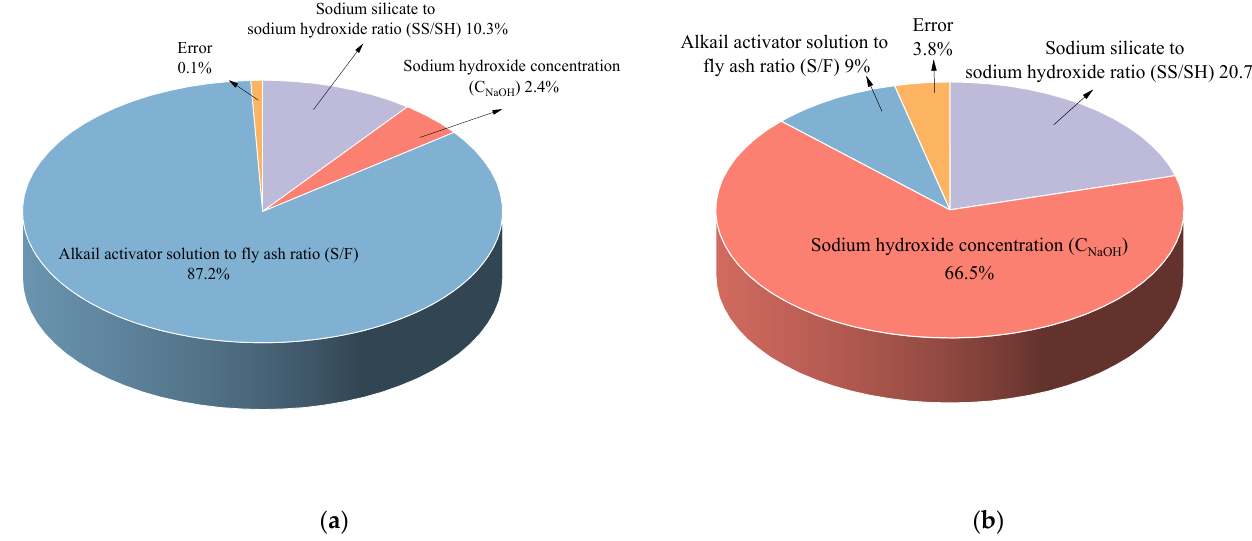
Table 6. Bonferroni analysis simplified results on SPSS